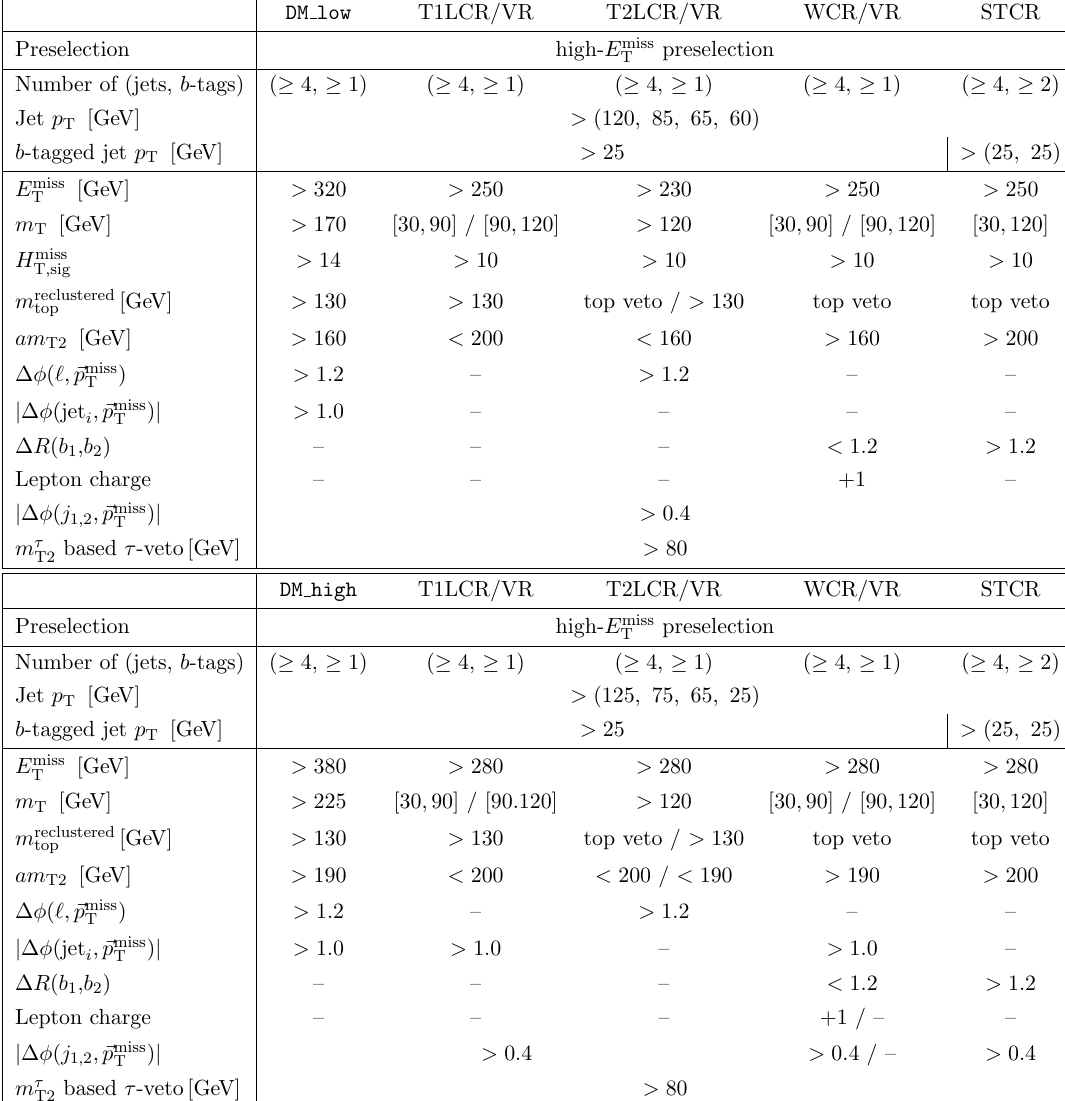
Table 14 . Overview of the selections for the DM low and DM high signal regions as well as the associated control and validation regions. The control regions include the semileptonic t (cid:22) t control region (T1LCR), the dileptonic t (cid:22) t control region (T2LCR), the W +jets control region (WCR), and the single-top Wt control region (STCR). The validation regions include the semileptonic t (cid:22) t validation region (T1LVR), the dileptonic t (cid:22) t validation region (T2LVR), and the W +jets validation region (WVR). List values are provided in between parentheses and square brackets denote